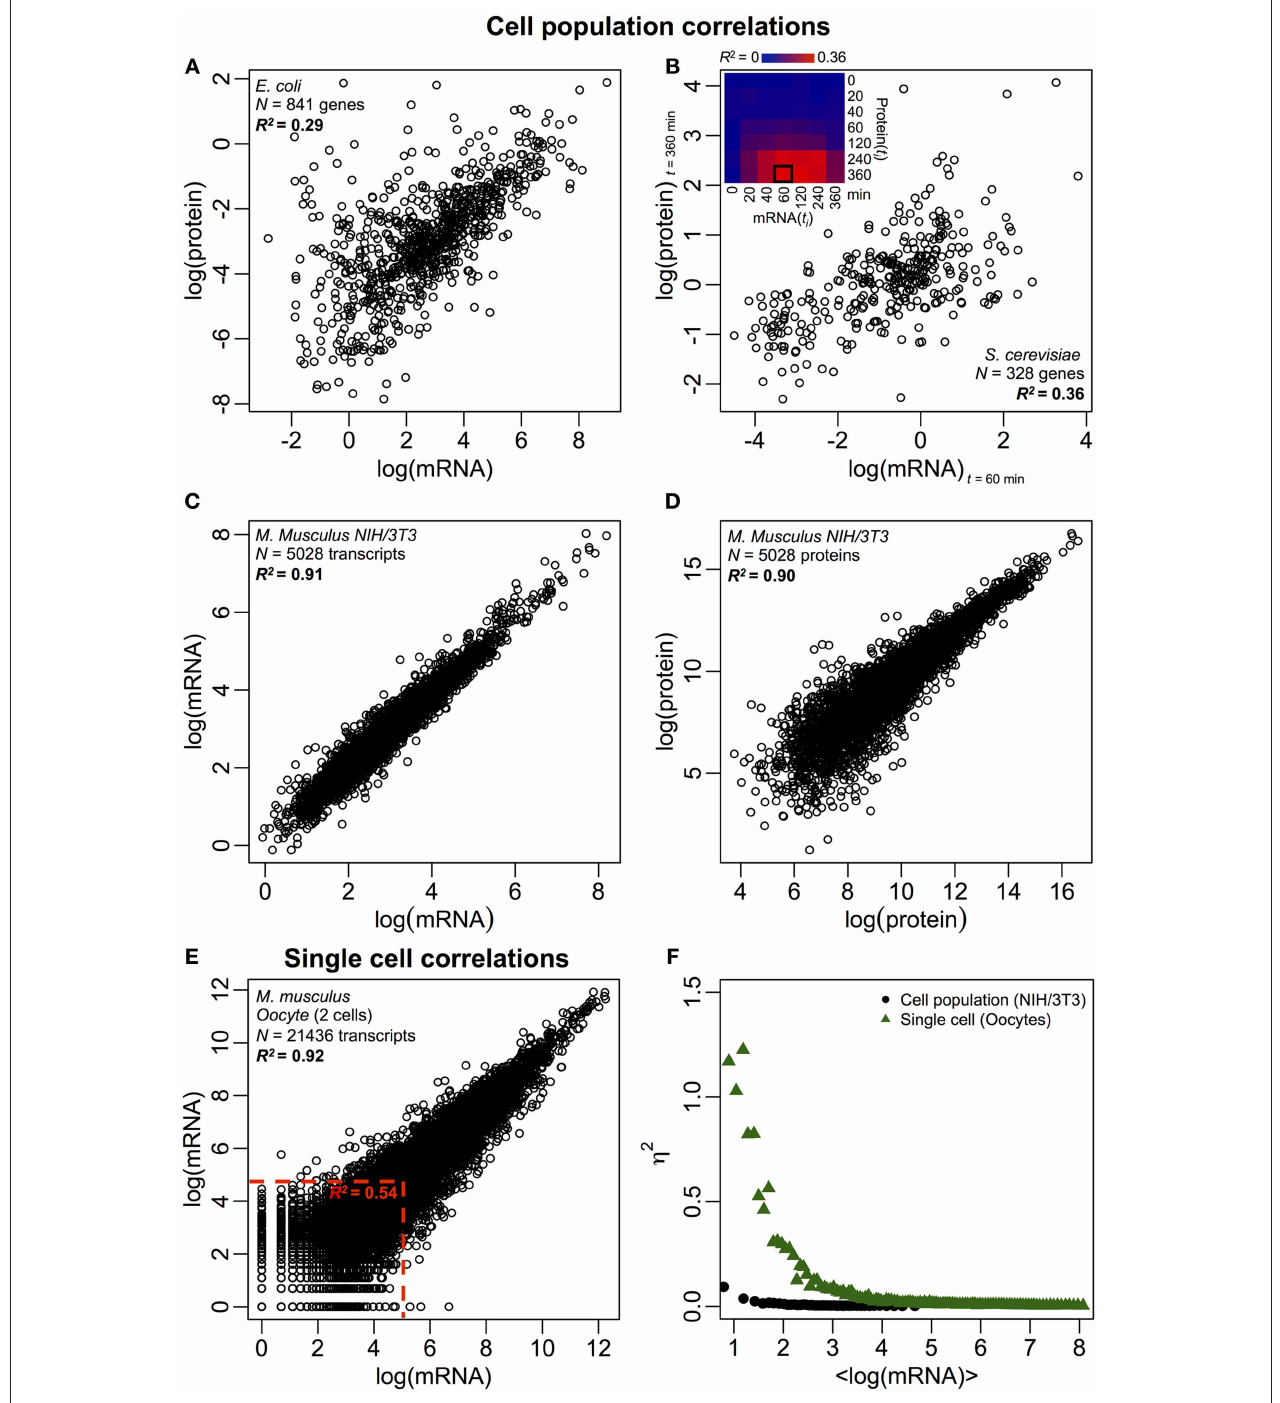
FIGURE 2 | Omics-wide expression correlations. Cell populations: mRNA-protein correlations in (A) E. coli (Taniguchi et al., 2010) and (B) S. cerevisiae (Fournier et al., 2010) between mRNA expressions at t = 60min and protein expressions at t = 360min. Insert: correlation matrix between all time points shows a delayed increase in correlations between mRNA and proteins. (C) mRNA and (D) protein expressions between two samples of murine NIH/3T3 cells (Schwanhäusser et al., 2011). Single cells: (E) mRNA expressions between two oocytes (Tang